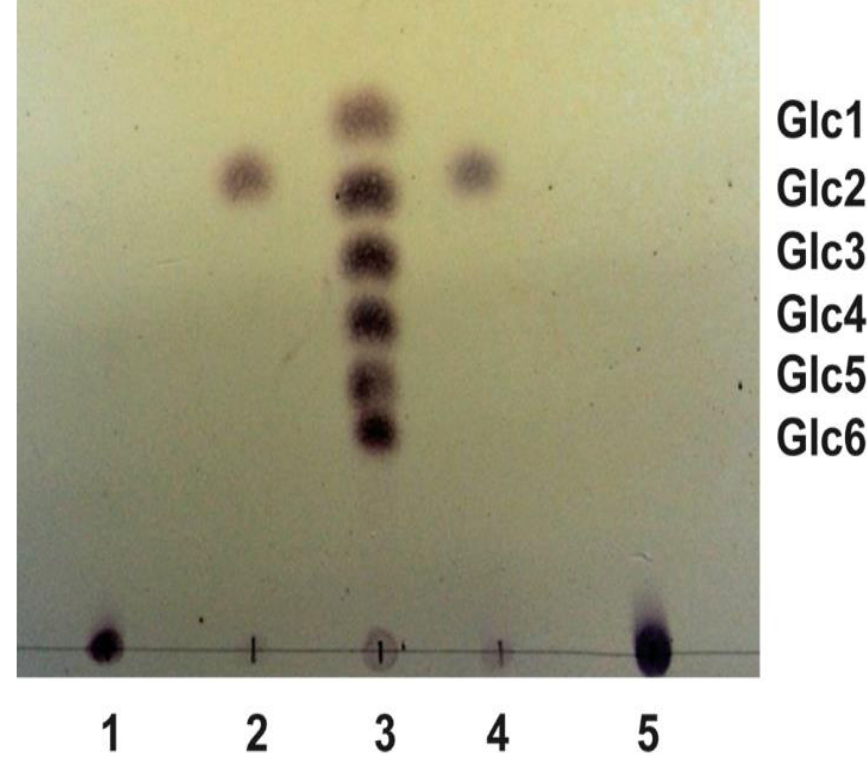
Figure 1. TLC of β -glucans hydrolyzed with lichenase. Lane 1: untreated R. etli ML β -Glucan; lane